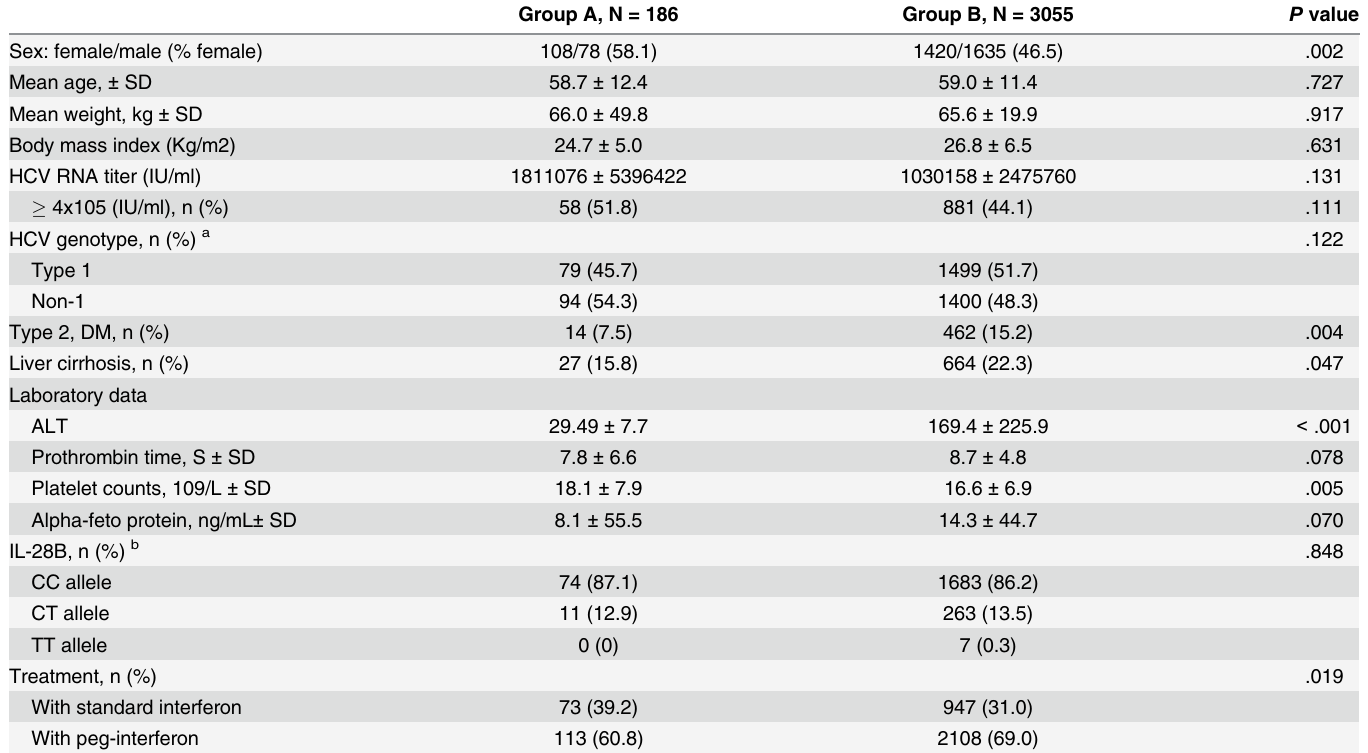
Table 1. Demographic, virological and clinical characteristics of the 3241 patients.